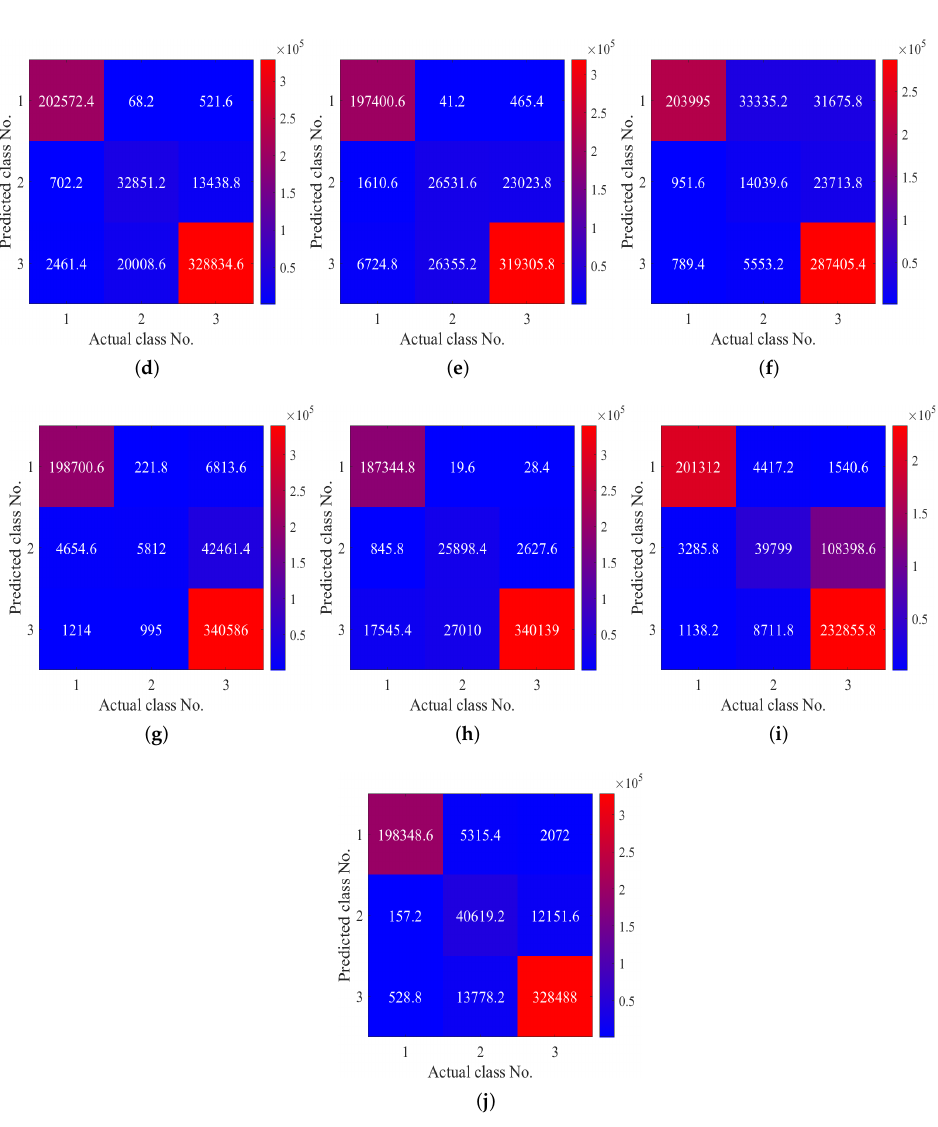
Figure A1. Confusion matrixes of classification results for San Francisco with different methods. ( a ) SVM.